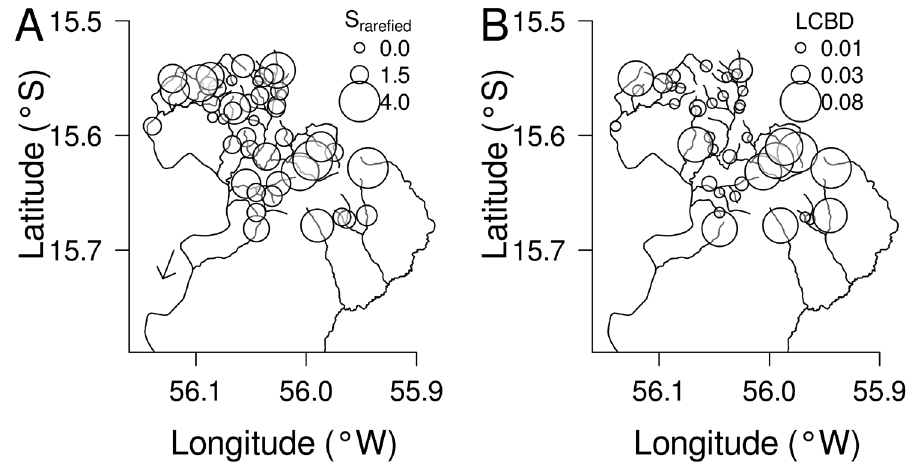
FIGURE 3 | Spatial variation in rarefied species richness (S Cuiabá (Mato Grosso, Brazil). The circle sizes in the legend indicate the minimum, mean, and maximum values of S arrow in “ A ” indicates flow direction.